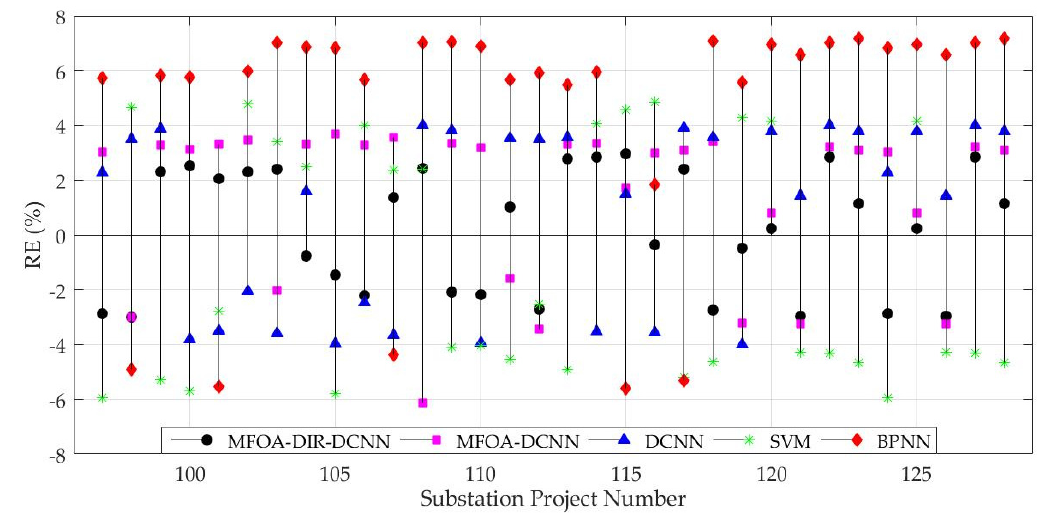
Figure 6. Relative error (RE) of prediction methods.